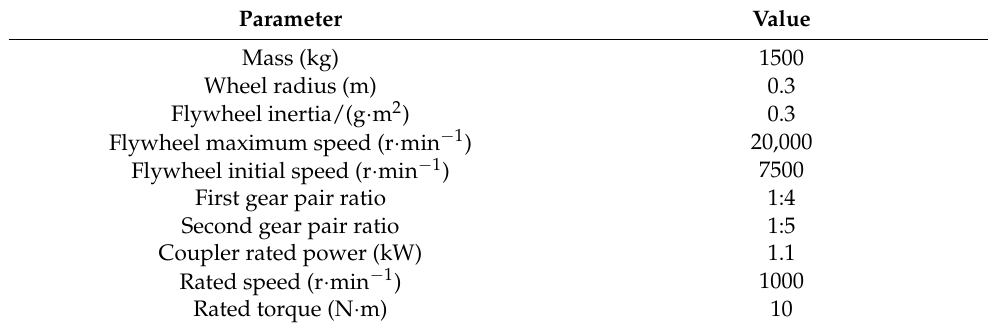
Table 2. Parameters of the